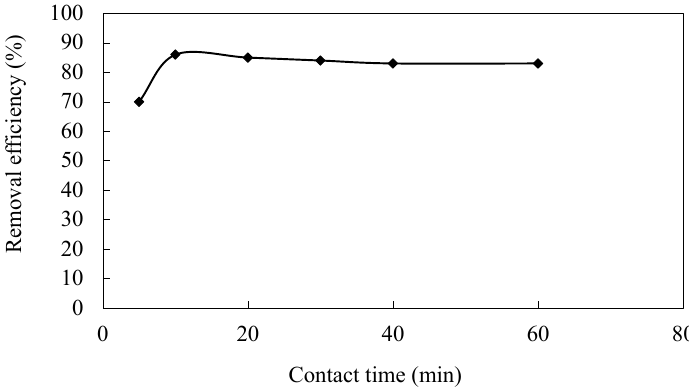
adsorbent.Fig. 7. The effect of contact time on the removal efficiency of Cd 2+ by the